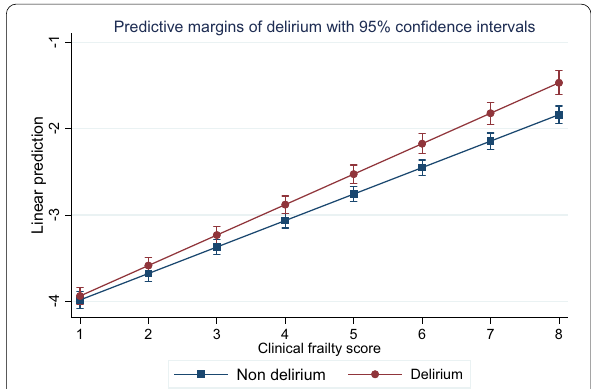
Fig. 2 The interaction between clinical frailty score and delirium on in‑hospital mortality